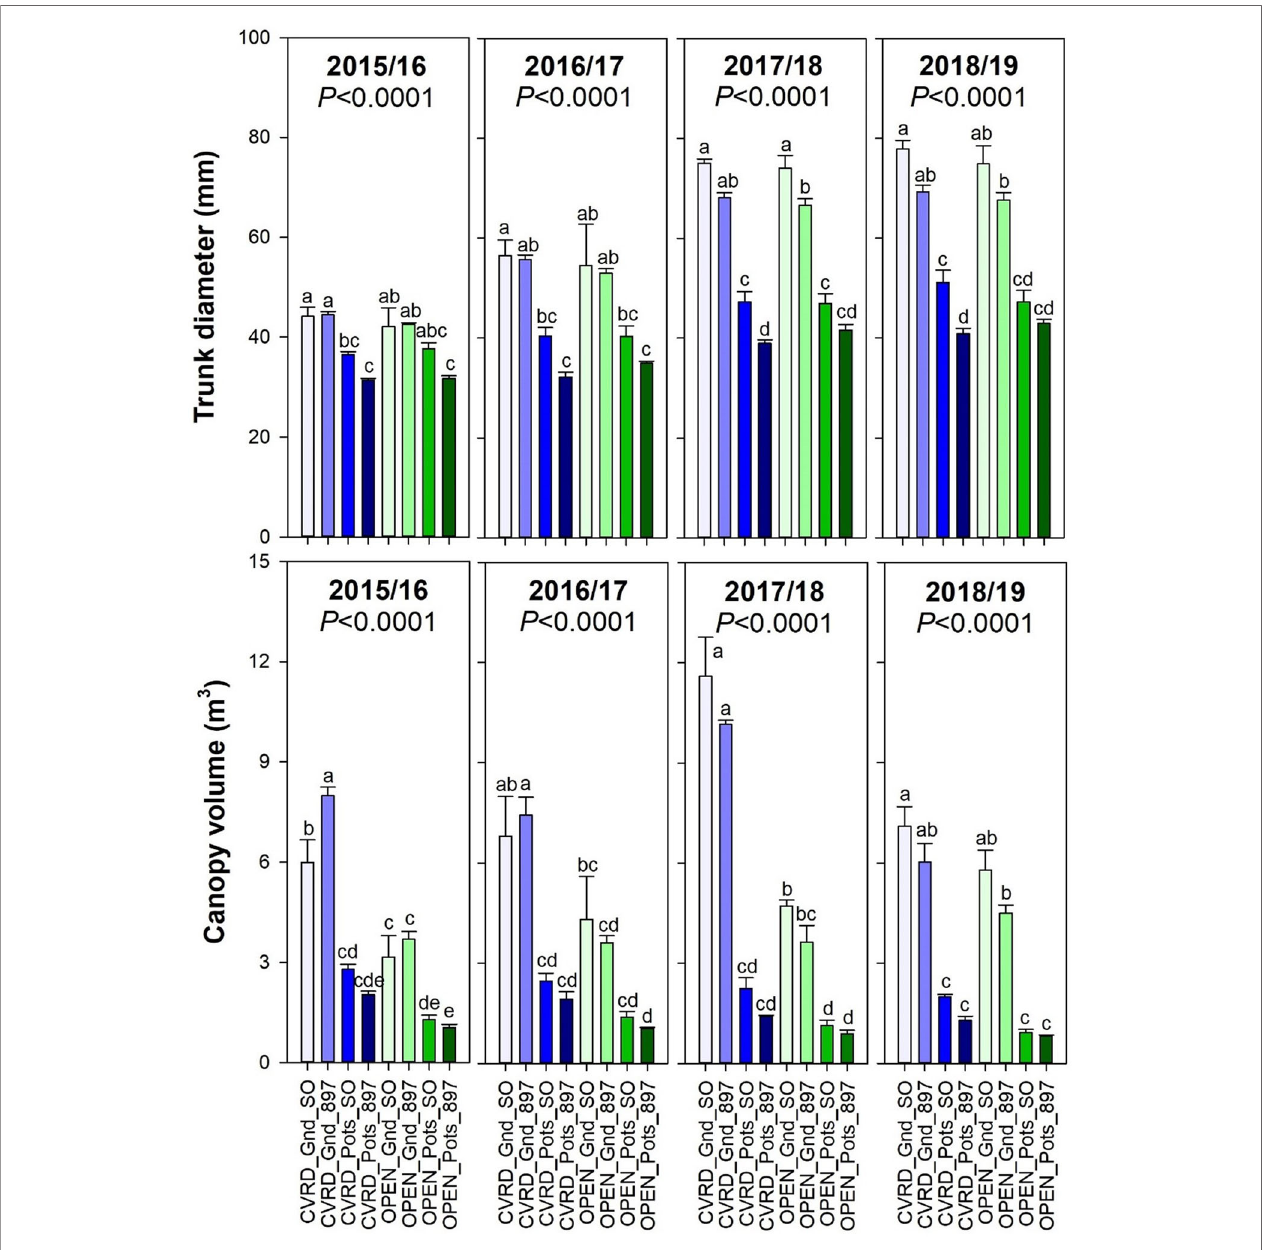
FIGURE 4 | Trunk diameter (top) and canopy volume (bottom) of “ Ray Ruby ” grapefruit trees cultivated under two production systems (screenhouse, CVRD and open-air, OPEN), two planting systems (in-ground, GND and potted, POTS), and two rootstocks ( “ Sour Orange, ” SO, and “ US-897 ” ), with four replications arranged in a split-split-plot experimental design. Mean ± standard error of four replications. Means with the same letter are not signi fi cantly different from each other at 5% probability ( P ≤ 0.05) using Tukey mean comparison